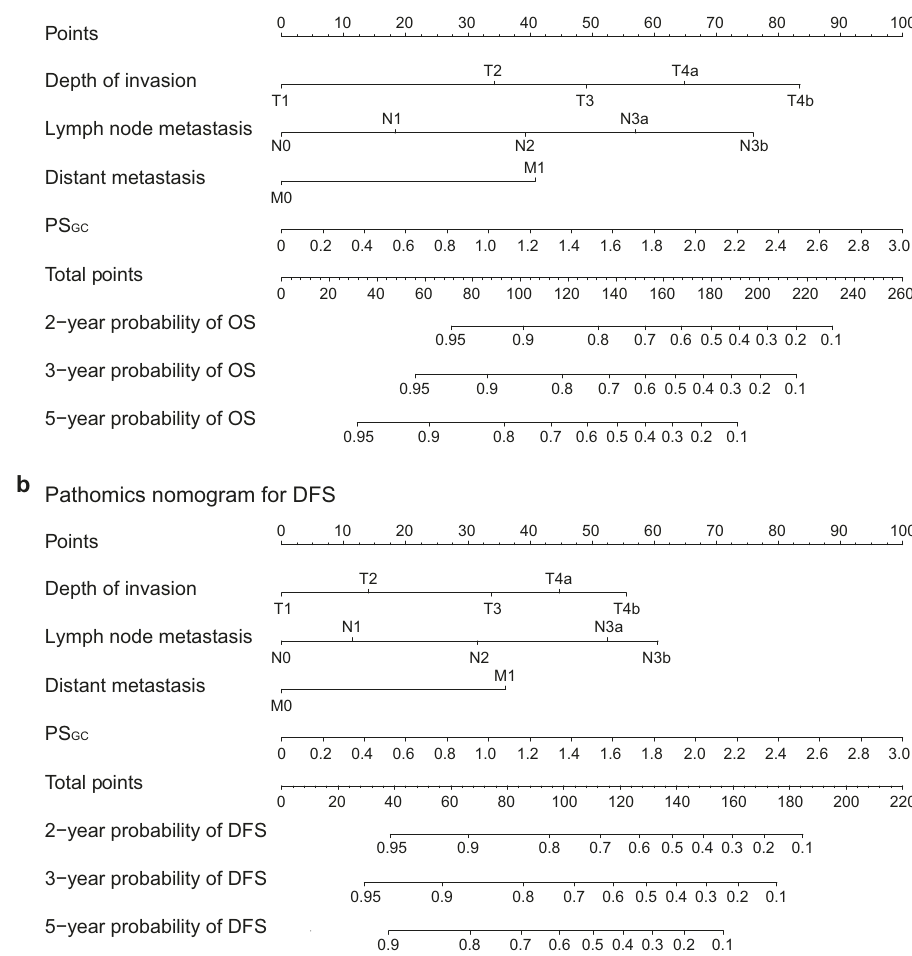
Fig. 3 | Pathomics nomograms for the prediction of OS and DFS. a Pathomics nomogram for OS. b Pathomics nomogram for DFS. The patient ’ s T stage on the depthoftheinvasionaxisis fi rstlocatedusingthenomogram.Then,alineisdrawn straight upward to the Points axis to determine how many points the patient receivesfromtheTstage.Thisprocessisrepeatedforeachvariable,andthepoints